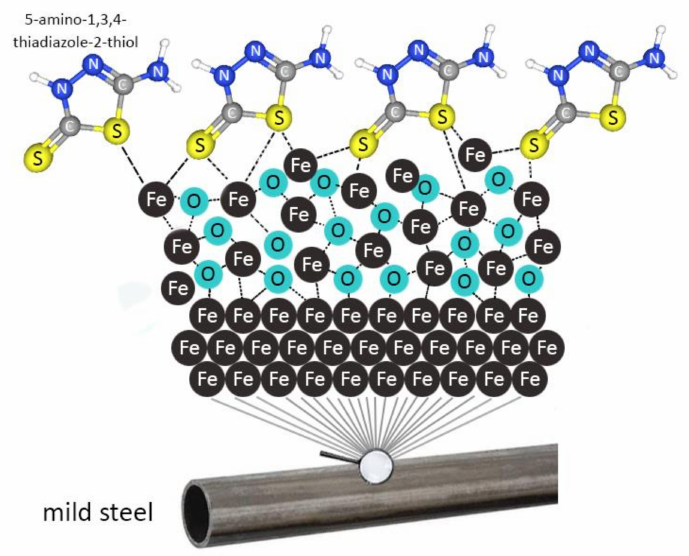
Figure 12. Schematic representation of the ATT connections onto the mild steel surface resulting in the formation of the protective